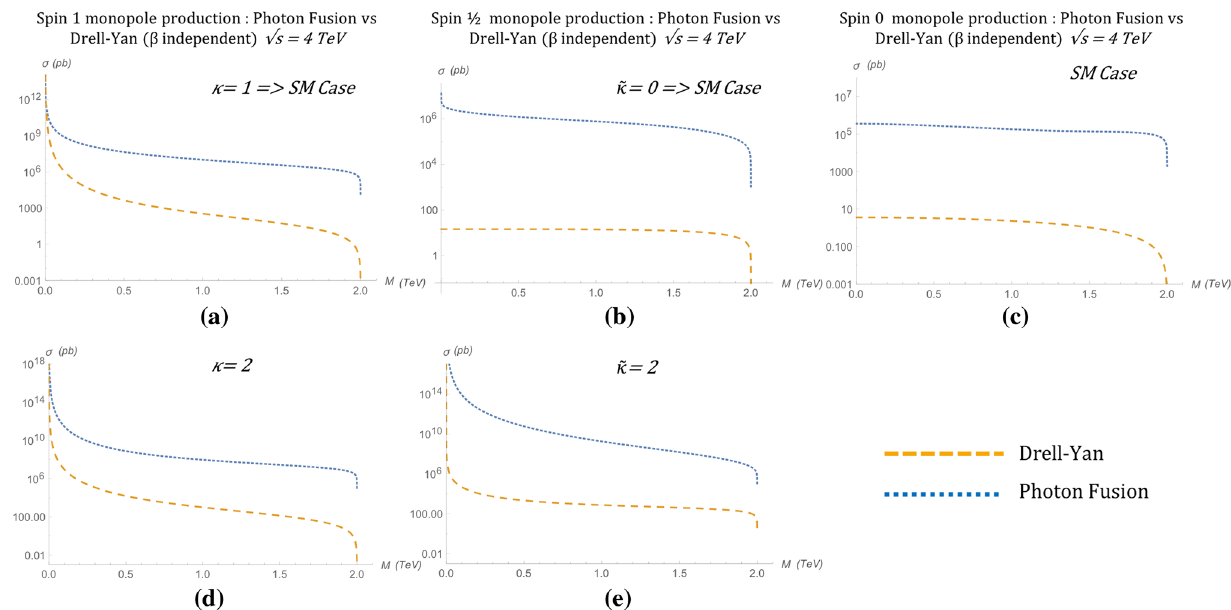
Fig. 20 Comparison between the cross sections of monopole pair pro- duction for PF and DY processes varying with monopole mass M at √ s qq /γγ = 4 TeV for β -independent coupling. (a) the spin-1 monopole in the SM-like case where κ = 1; (b) the spin- 1 / 2 monopole SM-like